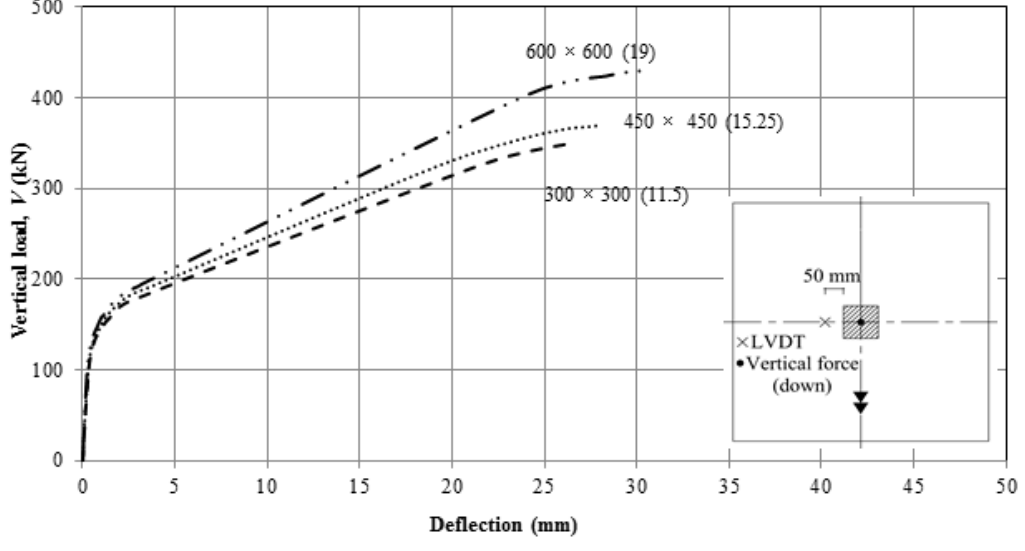
Figure 12. Load-deflection relationship for the models with different perimeter-to-depth